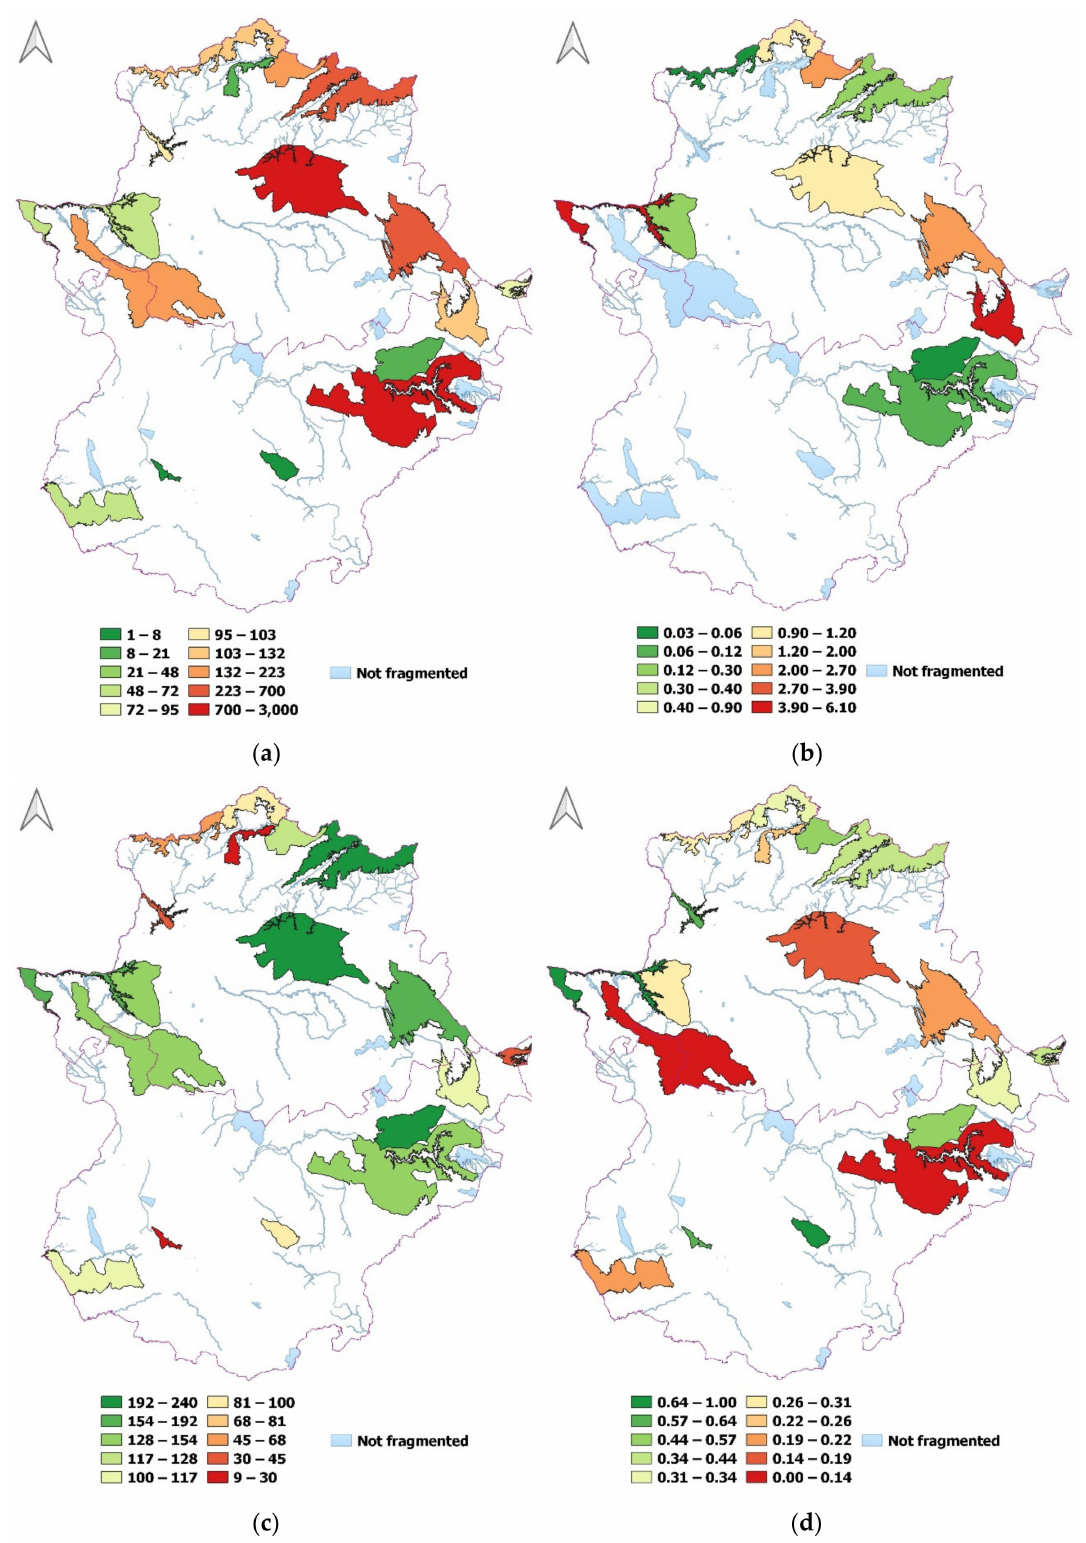
Figure 8. Landscape metrics obtained in relation to the Special Areas of Conservation (SACs) in Extremadura (Spain): ( a ) IFI, ( b ) UFI, ( c ) M eff (km 2 ) and ( d ) DIVI. The results of DIVI show, as a percentage of one, the proportion of the M eff over the total area of the LU. In smaller LU, this indicator makes it possible to determine